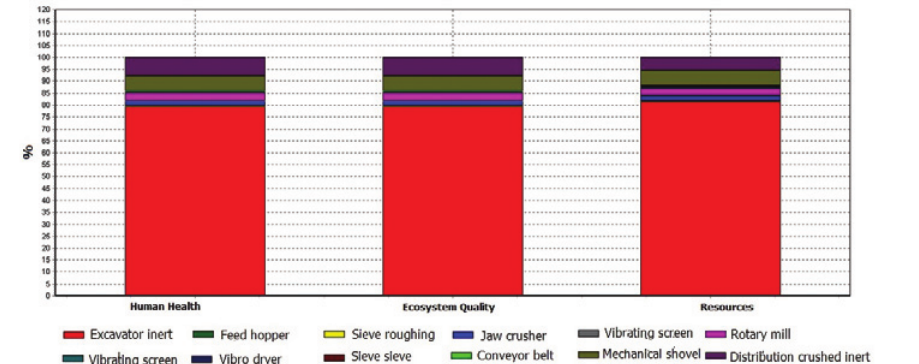
Fig. 7. Characterization of impact category for each phase of scenario 1 with Eco-Indicator 99 method